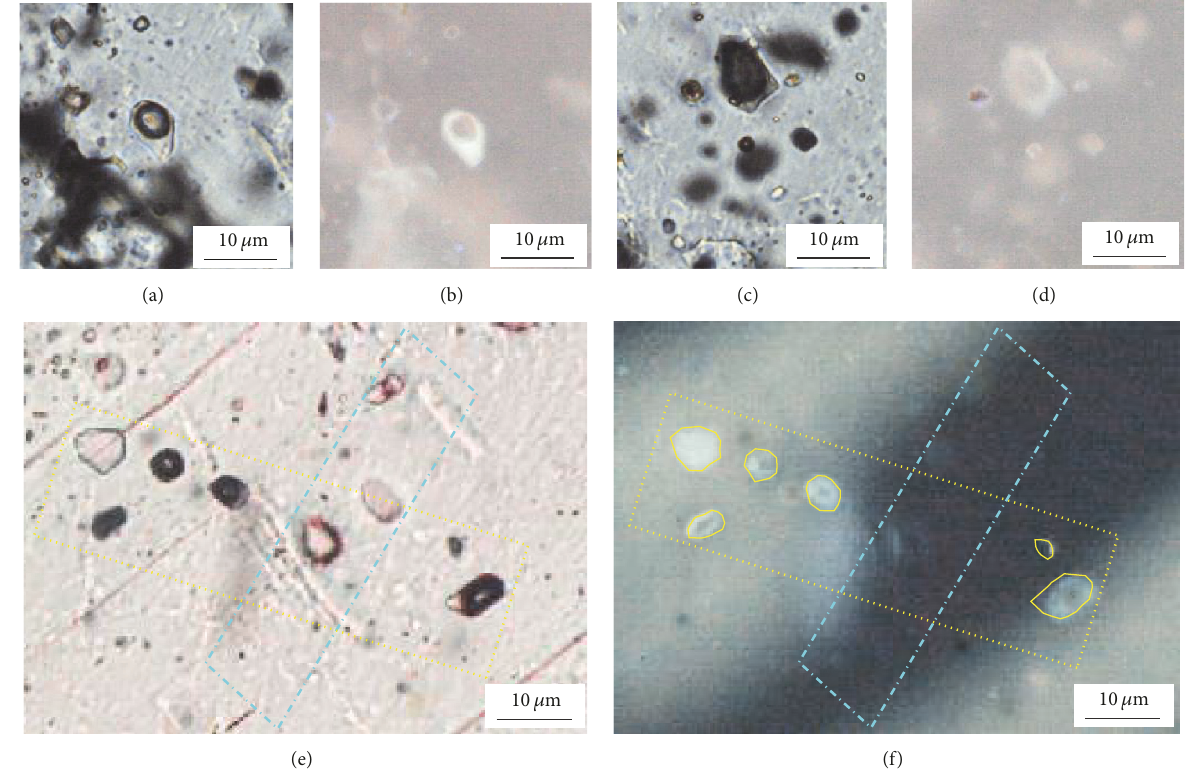
Figure 7: Photomicrographs of hydrocarbon-bearing inclusions at room temperature (20 ∘ C). ((a), (b)) Liquid-rich oil-bearing inclusion comprises oil and gas. The oil forms a yellow fluorescing. (c) (d) Vapor-rich oil-bearing inclusion contains oil and gas. The oil forms a thin cream fluorescing rim around the hydrocarbon gas bubble. ((e), (f)) A set of oil-bearing inclusions exhibit continuous different filling degrees (in yellow dotted line area) with yellow fluoresces, coexisting with two-phase type I FIs and one-phase CH 4 -rich inclusions (in blue dash dotted line area). Note: ((a), (c), (e)) under transmitted light, crossed-nicols; ((b), (d), (f)) under